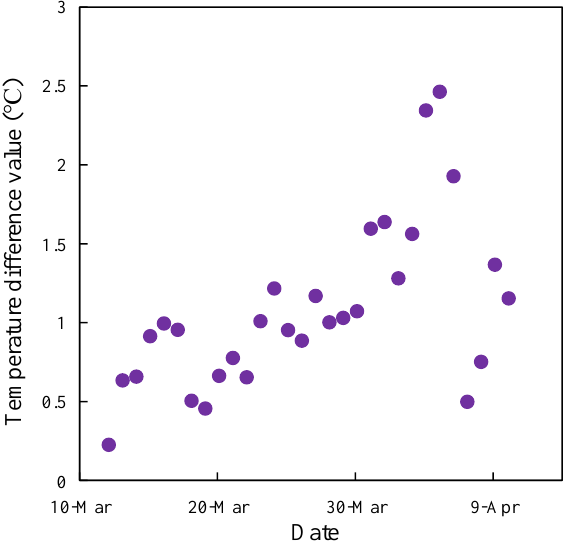
Figure 10. Daily temperature difference from 9:00 to 18:00 between W 0 and T 2 .